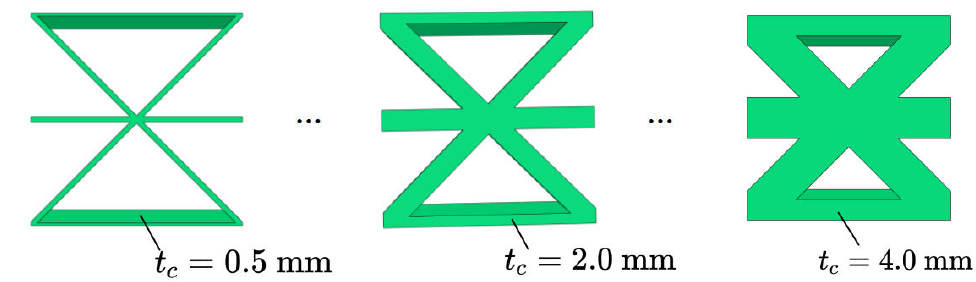
Figure 8. Geometric configurations of core cells with different core wall